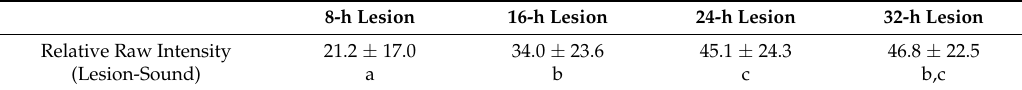
Table 3. Mean ± S.D. for raw intensity measurements of lesion windows subtracted by the measurements of their corresponding sound windows from NIR SFE images in the dry condition using 1460-nm light. Groups with the same letters are statistically similar, p > 0.05 in each row (n = 80).